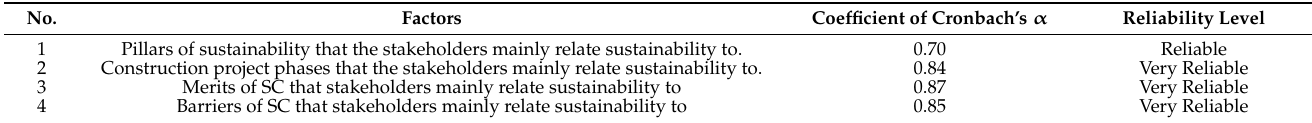
Table 4. Confirming data reliability using Coefficient of Cronbach’s